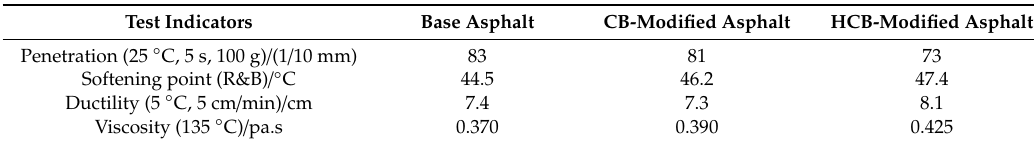
Figure 7. Effect of CB and HCB on phase angle of asphalt. 35